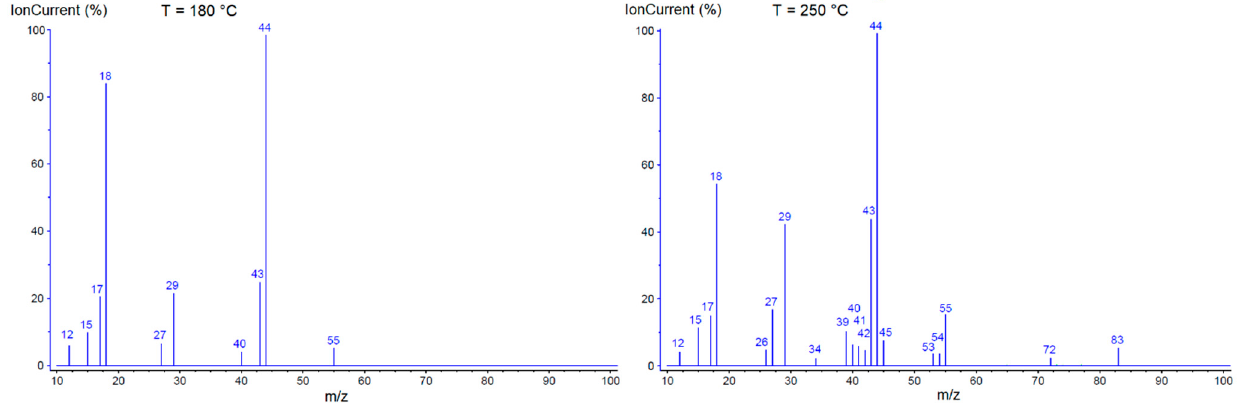
Figure 7. Mass spectra of volatile products from the thermal decomposition of [Cu 2 (tig) 4 (tigH) 2 ] registered at 180 °C and 250 °C. The elaboration of the mass spectra involved subtracting the background spectrum and application of an automatic software correction for the carrier gas.